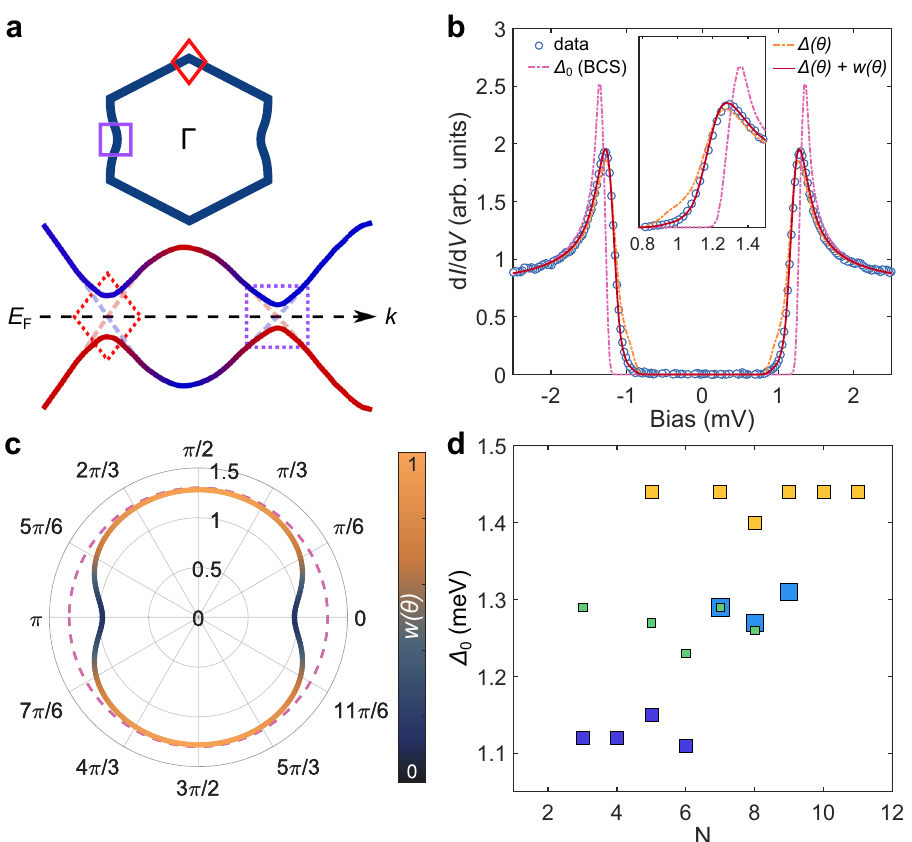
Fig. 5 Modeling the hybrid superconducting gap and extracting the anisotropic weighting function. a Top: sketch of the distorted Fermi surface for Pb/ BP showing the K (diamond) and M (square) points. Bottom: schematic band structure for the hybrid two-band model showing the BdG band dispersion and opening of an anisotropic gap. Dashed lines represent hybridized bands in the normal state. Dashed diamond and square shapes in the diagram represent the K and M points of the Fermi surface, respectively. b d I /d V spectrum (open blue circles) measured at T = 30 mK on a 7 ML fi lm (same as in Fig. 2a) together with the fi t employing a two-band model (red curve). The fi t uses an anisotropic gap ( Δ ( θ )) and an anisotropic density of states represented by a weight function ( w ( θ )) as shown in the polar plot in c . The magenta and orange curves in b represent simulated spectra with an isotropic gap (dashed line in c ) and an anisotropic gap without incorporating the weight function, respectively. d Δ 0 ( N ) obtained from fi tting plotted for different sample preparations measured at T = 30 mK. The different colors of scatter points represent different